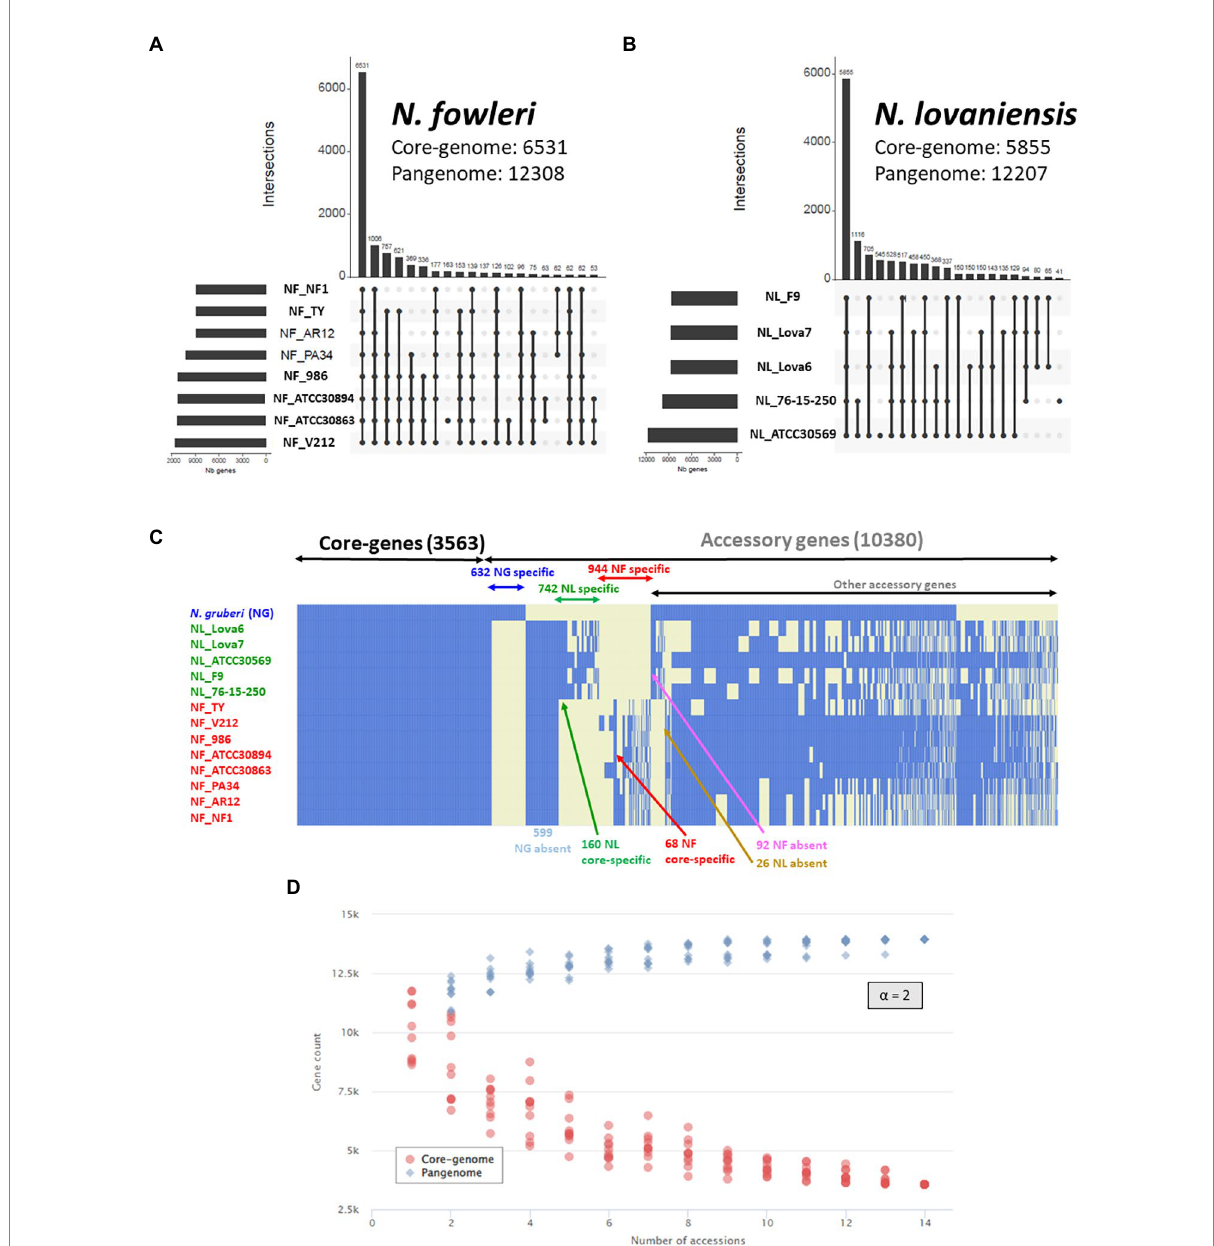
FIGURE 4 Naegleria pangenome analysis using OrthoFinder and visualized as UpSet and heatmap plots. UpSet plots show the intersections of the set of orthogroups from height genomes of N. fowleri (A) and five genomes of N. lovaniensis (B) species. Each vertical bar corresponds to a combination of gene sharing between strains. For each bar, black dots represent presence of the strain in the orthogroup while light gray dots denote its absence. Only the first 20 most abundant combinations are shown. The numbers of gene families (clusters/orthogroups) are indicated for each strain and strain intersection. (C) Gene presence/absence matrix for 14 strains of the three studied Naegleria species. The heatmap shows the presence (blue) or absence (light yellow) of all 13,943 orthogroups. Each row in the matrix corresponds to a strain/genome and each column represents an orthogroup. This representation has been conceived to visually separate Naegleria core-genes, species-specific genes and other accessory genes. (D) Gene accumulation curves showing how the Naegleria pangenome (blue) and core-genome (blue) vary as genomes are added in random order to the analysis. The power law alpha parameter shown inside the plot equals 2, which is indicative of a closed